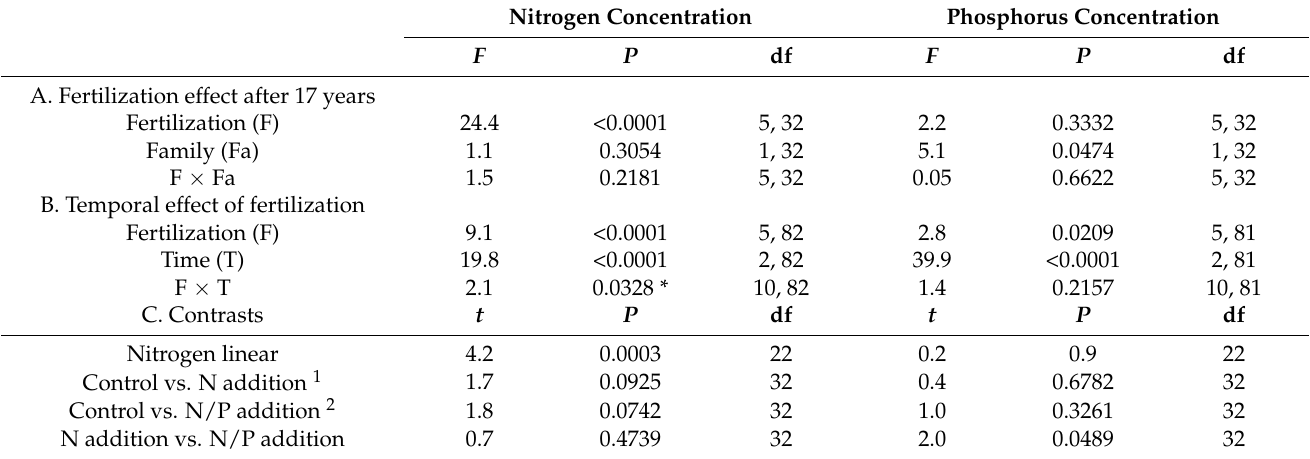
Table 5. Results of linear mixed models evaluating the effects of (A) fertilization after 17 years, graminoid families ( Cyperaceae , Poaceae ) and their interaction, and (B) fertilization, time after initiation of the experiment (2, 5 and 17 years) and their interaction on the N and P concentration of graminoid plants in the tundra wetlands of Bylot Island, Nunavut. (C) A priori contrasts were also applied on fertilization effects after 17 years.